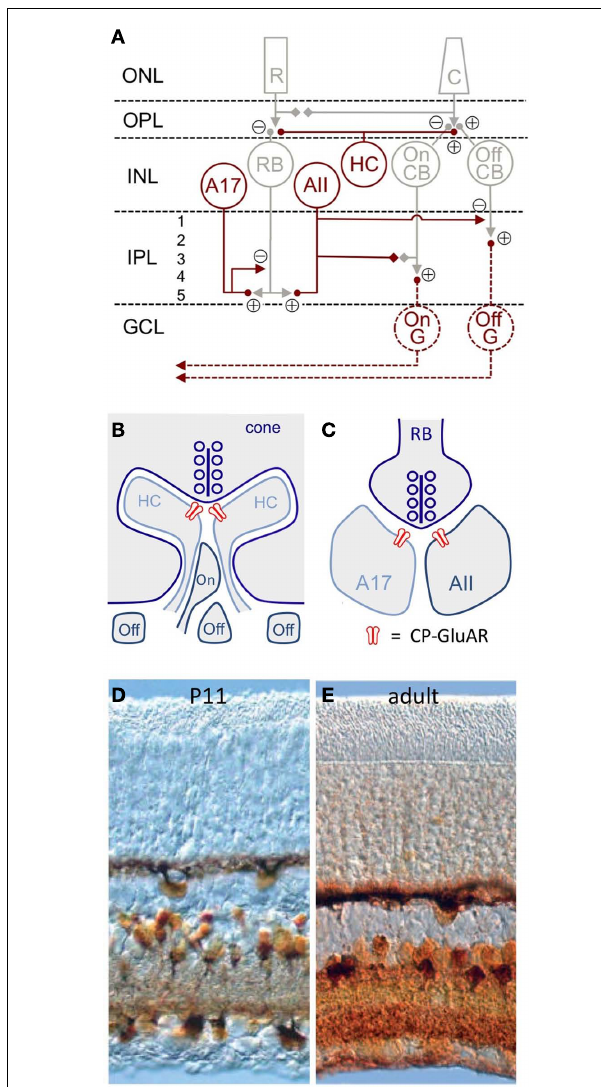
FIGURE 1 | CP-GluAR expression in the retina. (A) Schematic of mammalian retina (Vaney et al., 1991). CP-GluAR + cell types are highlighted in amber; GCs are hatched because the express CP-GluARs primarily early in development. R, rod; C, cone; RB, rod bipolar cell; HC, horizontal cell; CB, cone bipolar cell; G, ganglion cell; ONL, outer nuclear layer; OPL, outer plexiform layer; INL, inner nuclear layer; IPL, inner plexiform layer; GCL, ganglion cell layer. (B) Schematic showing triad synapse in the OPL between presynaptic cone photoreceptors and postsynaptic horizontal cells and bipolar cells. Modified from DeVries (2000). (C) Schematic showing dyad synapse in IPL between presynaptic rod bipolar cell and postsynaptic A17 and AII amacrine cells. In (B,C) CP-GluARs are indicated in red. (D) Co 2 + staining in the P11 rat retina shows functional CP-GluAR expression in horizontal cells, amacrine cells, and ganglion cells (Osswald et al., 2007). (E) CP-GluAR expression is reduced in adult ganglion cells (Osswald et al.,